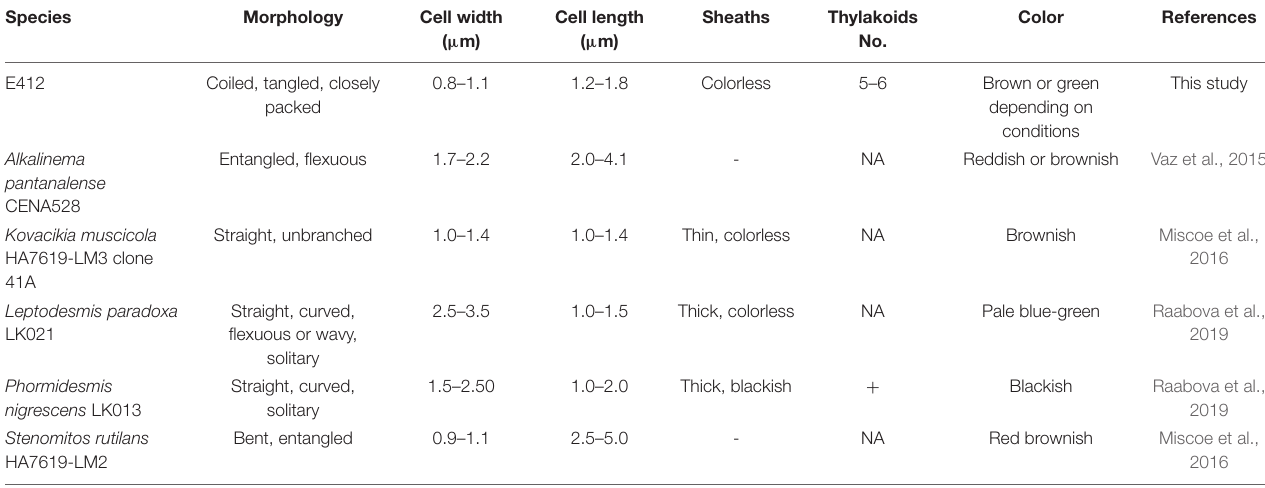
TABLE 4 | Comparison of morphological features of Leptolyngbyaceae